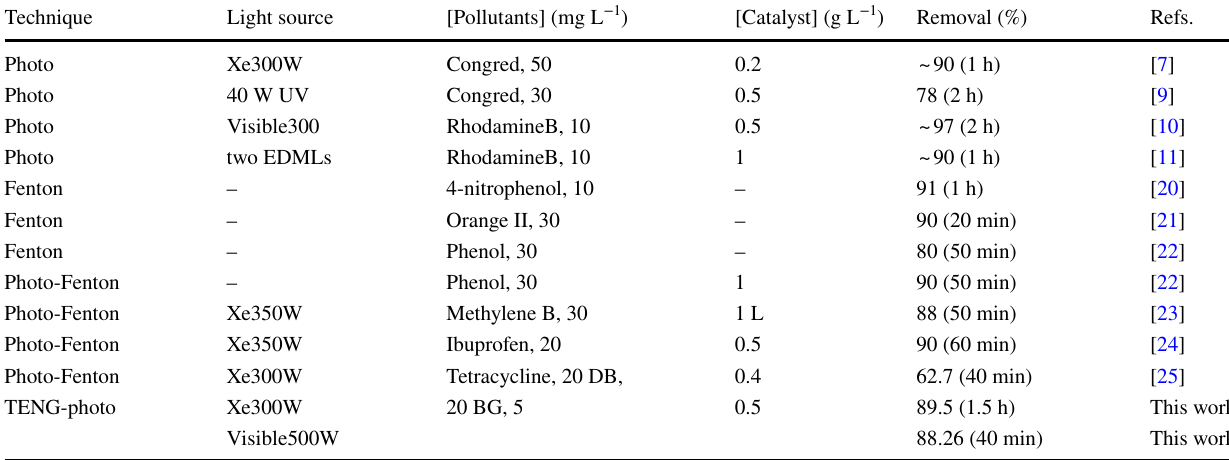
Table 1 Comparison of pollutants degradation over different techniques Technique Light